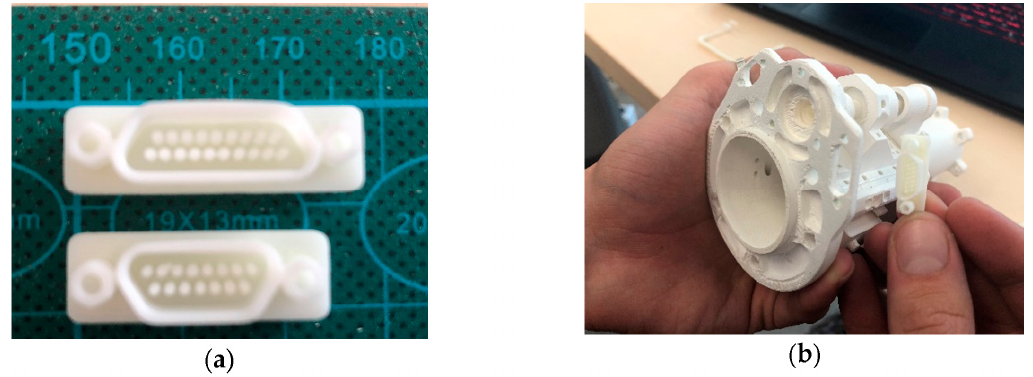
Figure 9. ( a ) Subassembly 8 connectors. ( b ) Connector and printed piece of Subassembly 8.